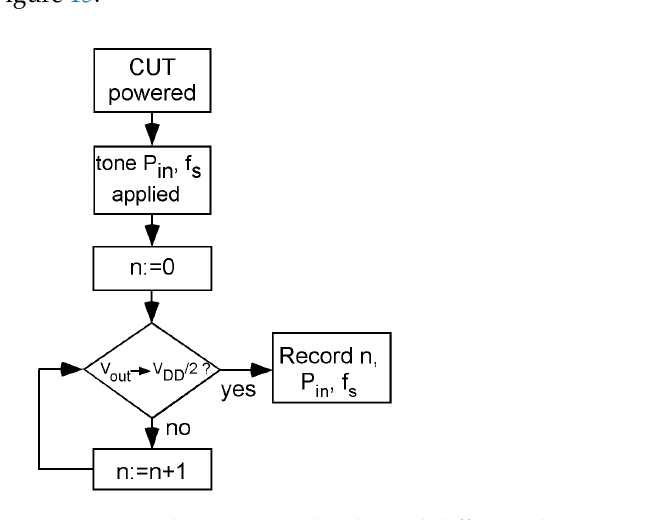
Figure 15. Algorithm to monitor aging in the PA using the thermal differential sensor with the homodyne technique.